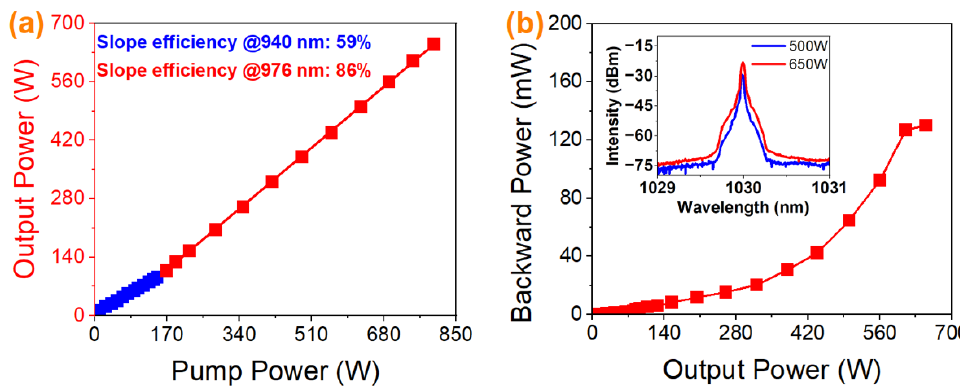
Figure 3. ( a ) Output power versus pump power. ( b ) Backward propagating power versus output power. Inset: Backward spectra within the wavelength range of 1029 – 1031 nm.